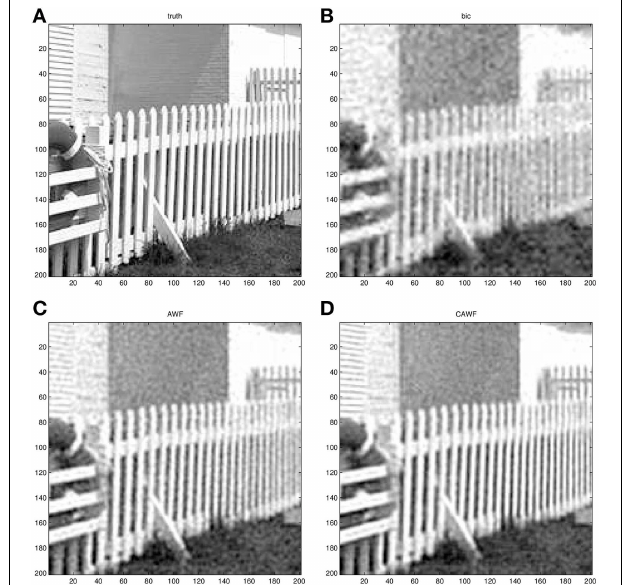
FIGURE 6 | The first Lighthouse ROI. (A) The truth image, (B) bicubic output image, (C) AWF SR output image, and (D) the CAWF output image. Processing is done using L